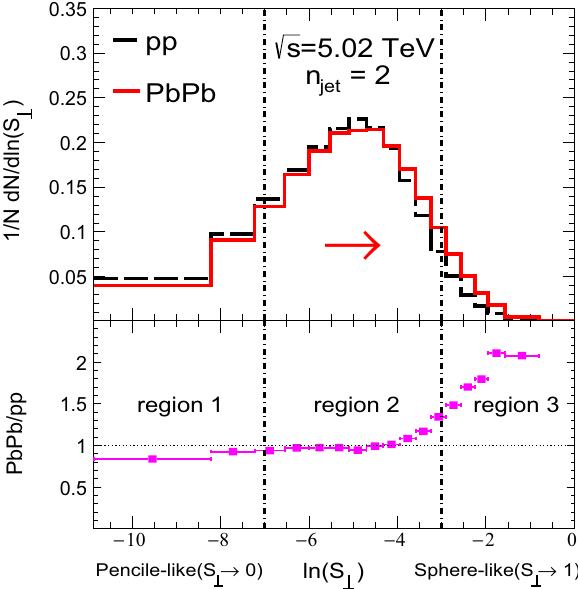
Fig. 4 Top: event normalized transverse sphericity distribution of √ n jet = 2 events in p+p and Pb+Pb collisions at s = 5 . 02 TeV; bottom: tom: medium modification factor of event normalized S ⊥ distribution of n jet = 2